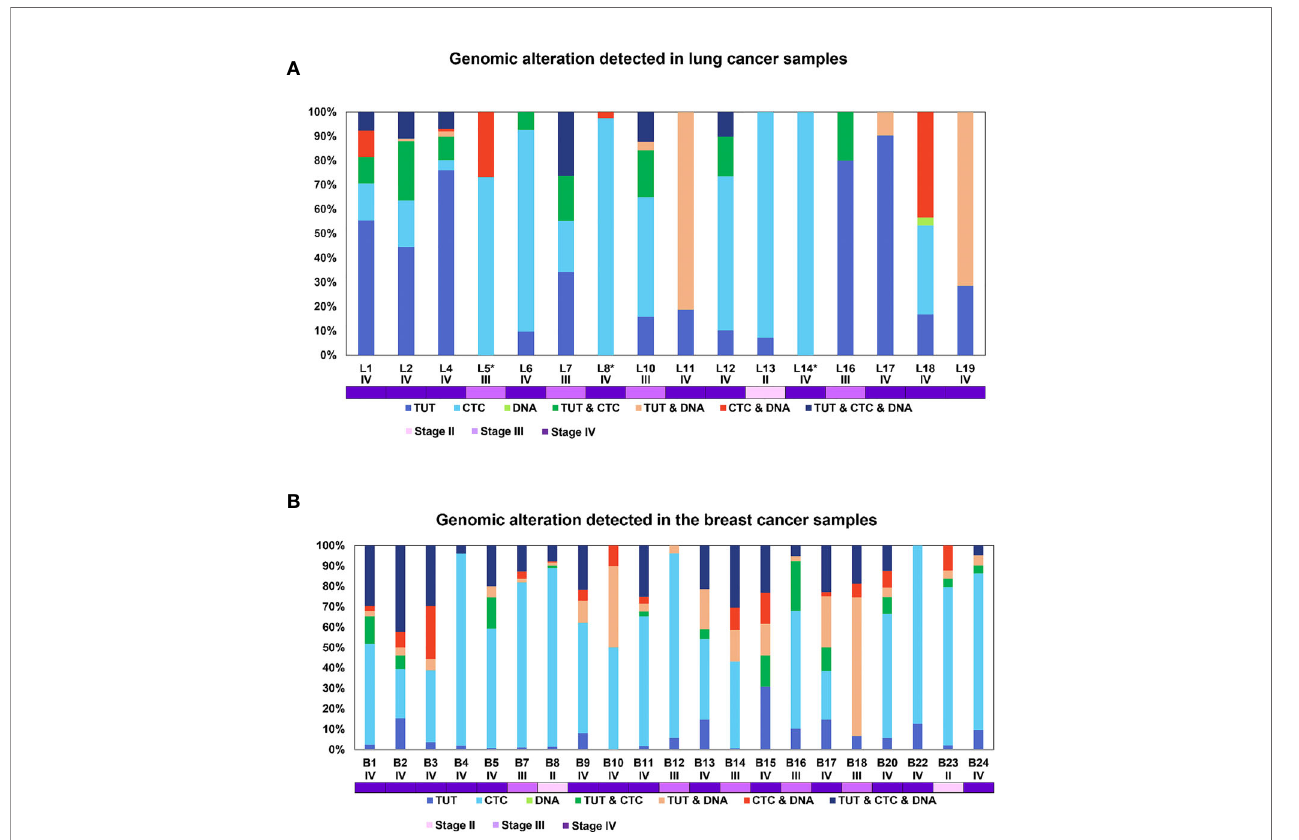
FIGURE 4 | The con fi guration of the genomic alterations detected in (A) lung and (B) breast cancer samples. The mutations are grouped according to their occurrence, either private or commonly found in tissue, CTCs or ctDNA. The disease stage of each patient is represented by the different tones of purple colors.